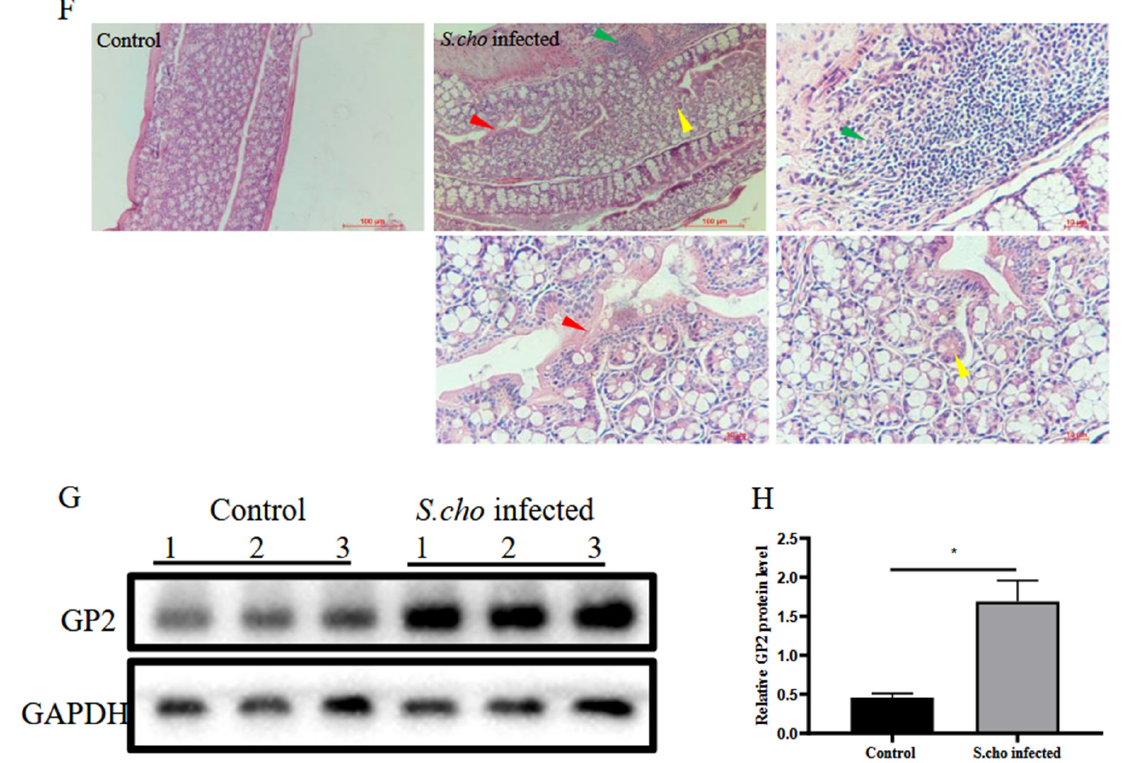
Figure 2. S. choleraesuis infection induces colitis and M cell differentiation. WT mice were gavaged with S. choleraesuis -PBS buffer mix ( S. choleraesuis -infected group, n = 3) or normal PBS buffer (control group, n = 3). Their body weight was monitored daily ( A ). The mice were sacrificed on day 8, and the spleen weight, colon weight, and colon length were evaluated to assess the pathological changes caused by S. choleraesuis infection ( B ). The bacterial loads in the liver, spleen were analyzed ( C ). Total RNA from colon samples was used to detect the mRNA level of TNF- α , IL-1 β , IL-6 by RT-qPCR ( D ). Total RNA from colon samples was used to detect the mRNA levels of GP2, Spi-B, RANK, Tnfaip2, and CCL9 by RT-qPCR ( E ). The data were calculated using the 2 − ∆∆ Ct method. Tissue samples from the colon were used for histological analysis for assessing colitis ( F ). The GP2 expression levels in total protein from colon samples were evaluated by Western-blot ( G ). Relative GP2 protein level was determined from the band intensity using ImageJ software ( H ). In all graphs, data are shown as ‘mean ± SEM’. Results were designated with: NS, p > 0.05; * p < 0.05; ** p <